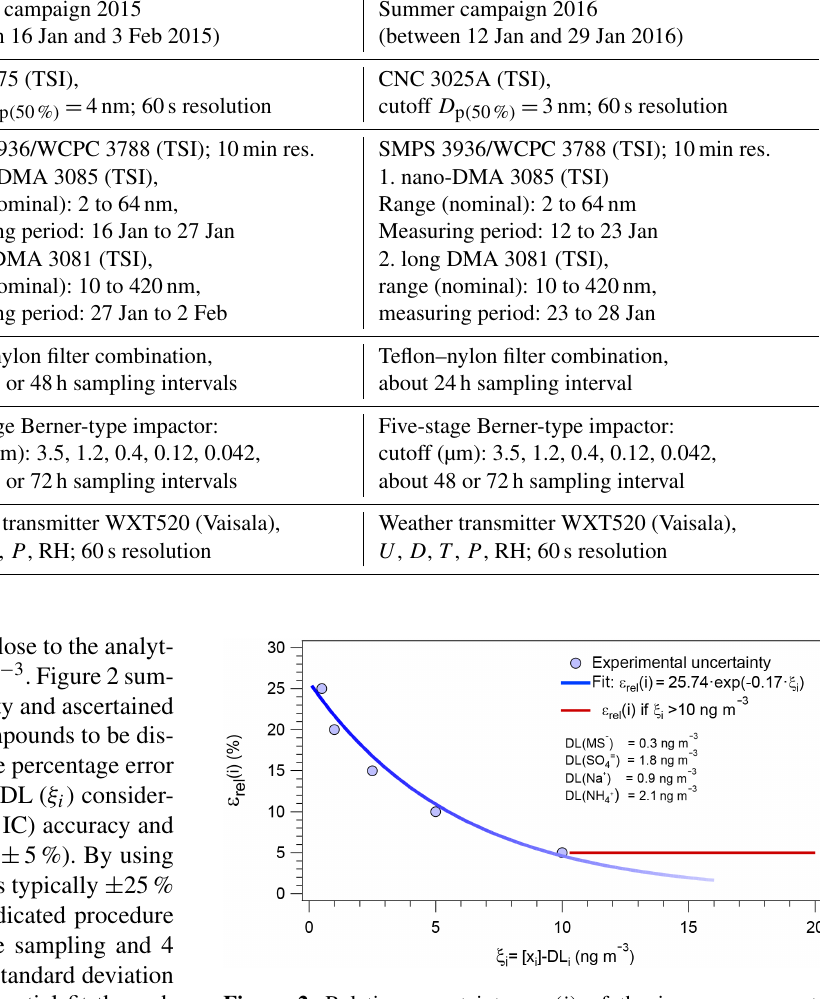
Figure 2. Relative uncertainty ε rel (i) of the ion measurements derived from bulk (low volume) and size-segregated (Berner im- pactor) sampling as a function of ξ i . The circles represent the per- centage error at different concentrations ξ i , i.e., the measured con- centration of the ion [ x i ] minus the corresponding DL i . The blue line is an exponential fit through these values. Above a concentra- tion of around 10ngm − 3 , the uncertainty was mainly governed by the concentration-independent volume ascertainment of around 5% (red horizontal